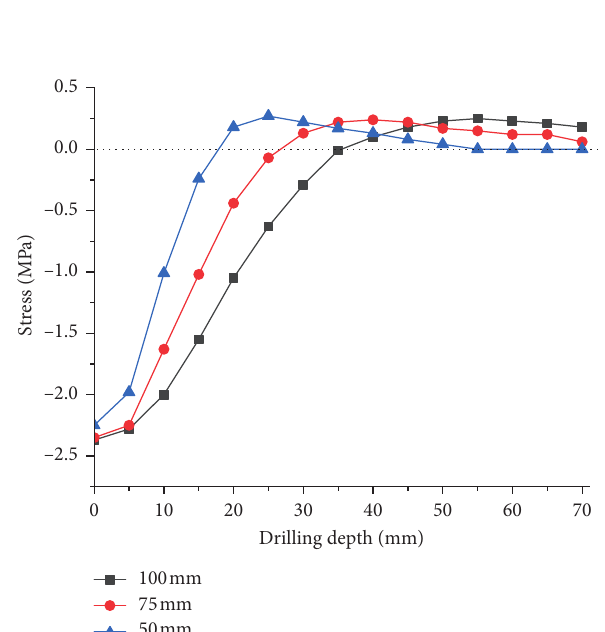
Figure 4: Relationship between stress and drilling depth for dif- ferent borehole diameters.